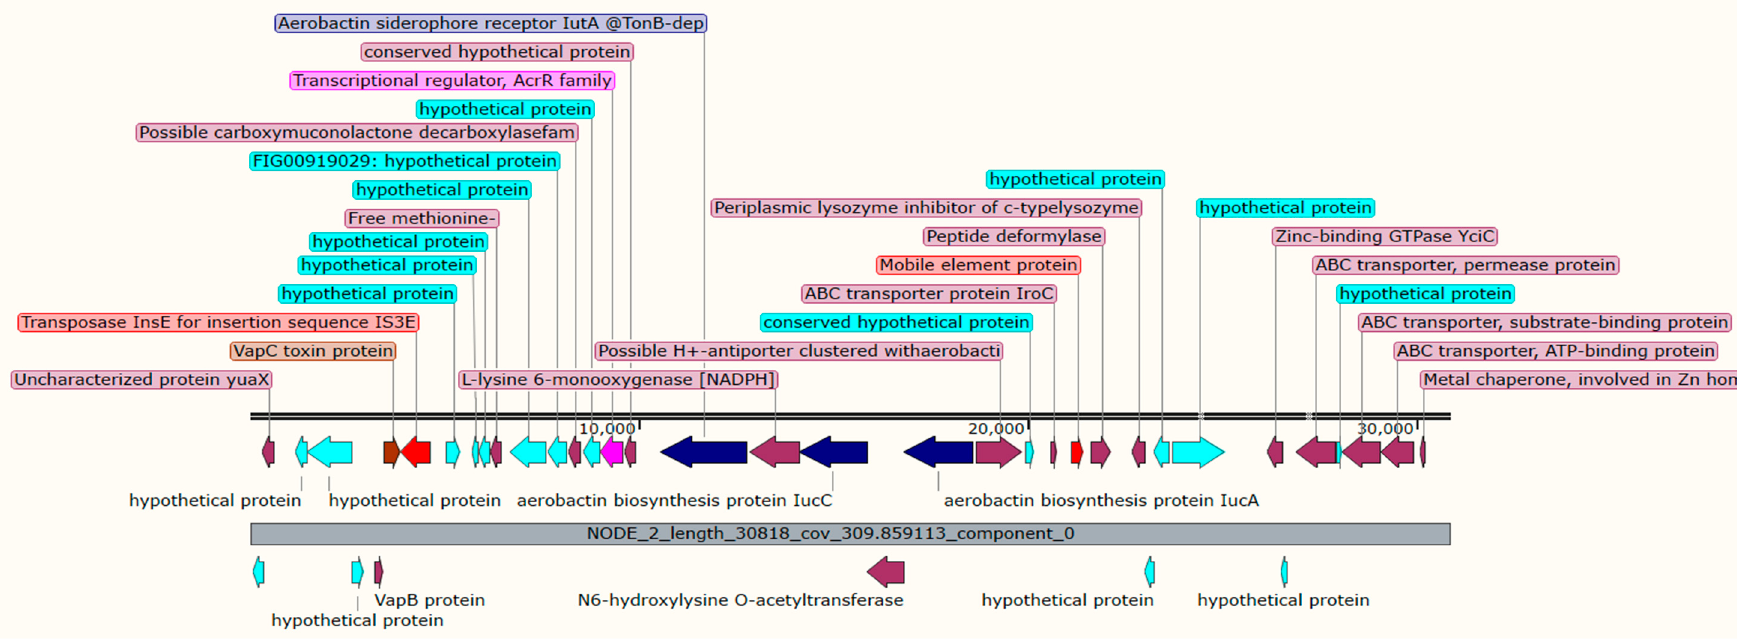
Figure 5. A cluster of plasmid-mediated aerobactin synthesis genes ( iucA , iucB , iucC , iucD , and iutA ) (blue), IS3E, mobile element (red), VapC toxin protein (brown), VapB protein and transcriptional regulator ( AcrR ) (light brown), observed in the plasmid p EC422_4 of isolate K7.